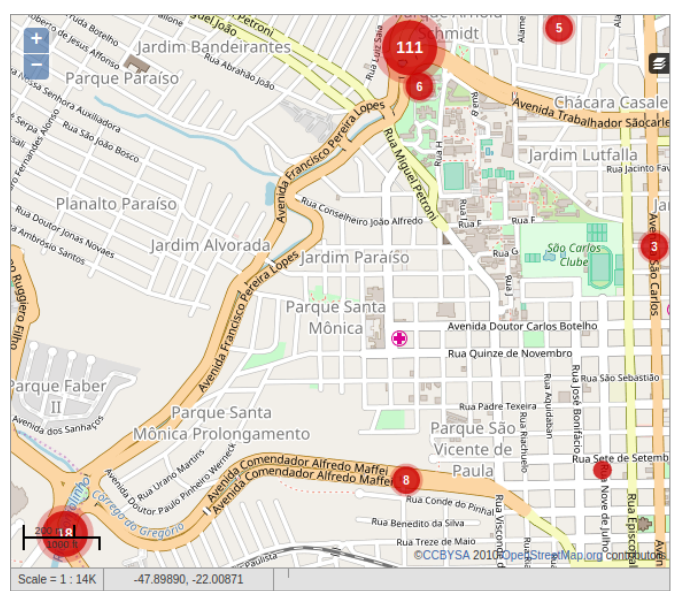
Figure 18. Flood Citizen Observatory.